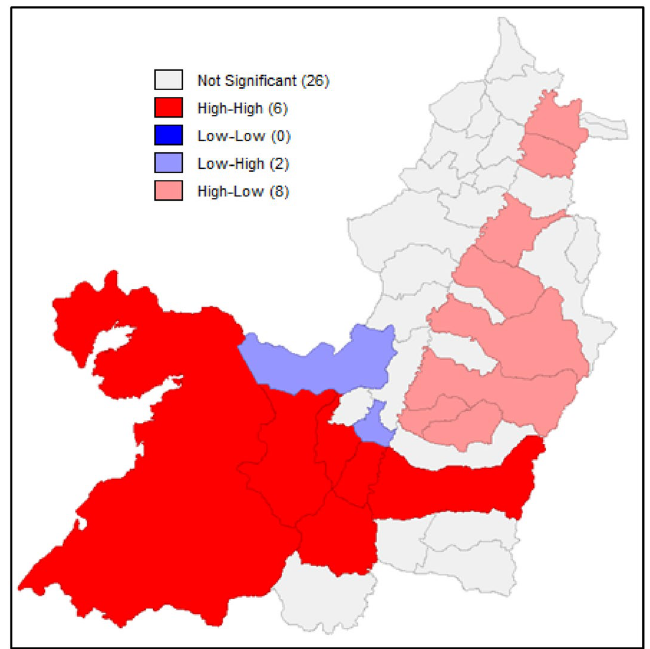
Fig. 3 Bivariate Moran Index between the 2014 fiscal efficiency and the categorization of the area (by metropolitan area). Source: own computation based upon GeoDa